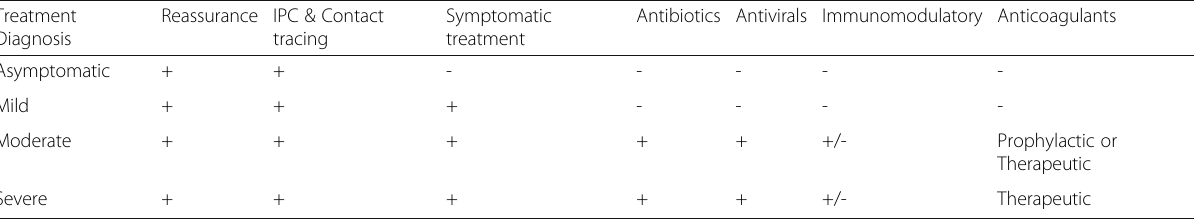
Table 1 Key recommendations for treating pediatric COVID-19 patients according to severity of disease Treatment